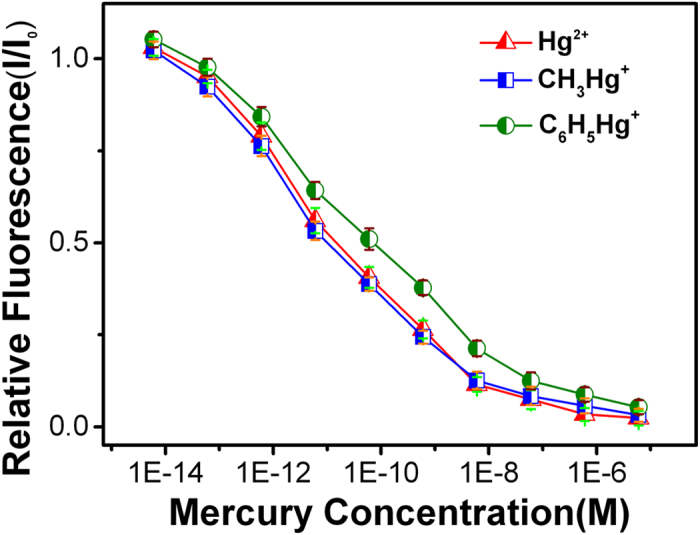
Normalized fluorescence intensity variation (I/I0) of R6G/MPA-NPG as a function of mercury ion (Hg2+, CH3Hg+ and C6H5Hg+) concentration.